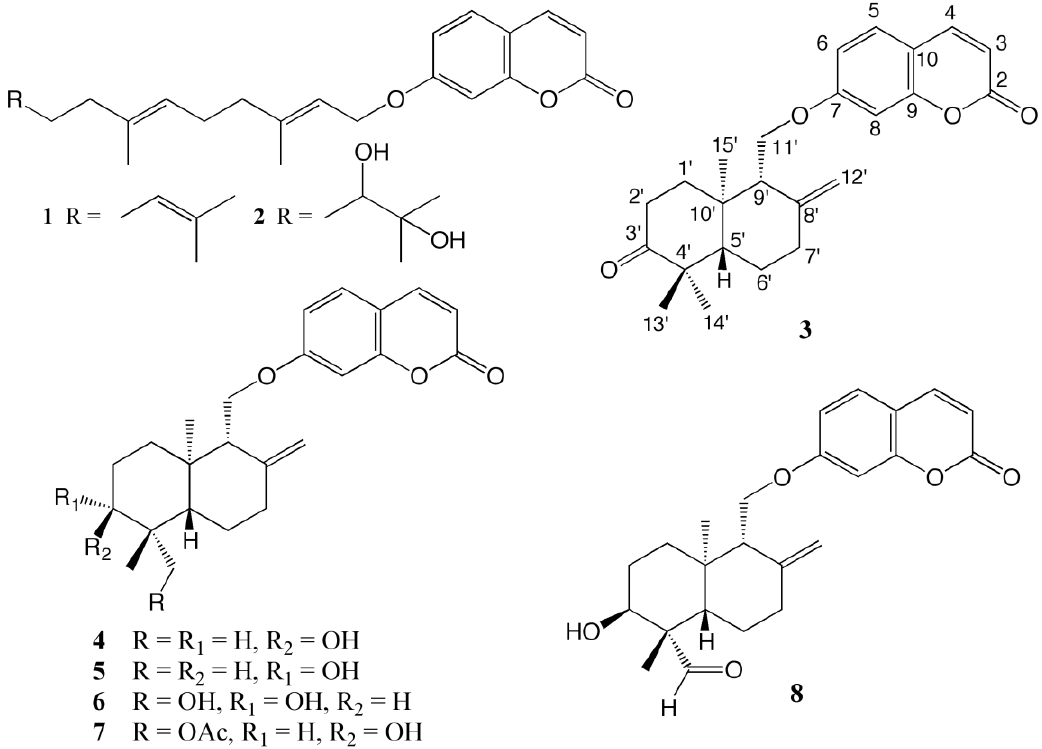
Figure 1. Structures of the sesquiterpene coumarins isolated from the dichloromethane extract of the roots of Heptaptera anatolica .